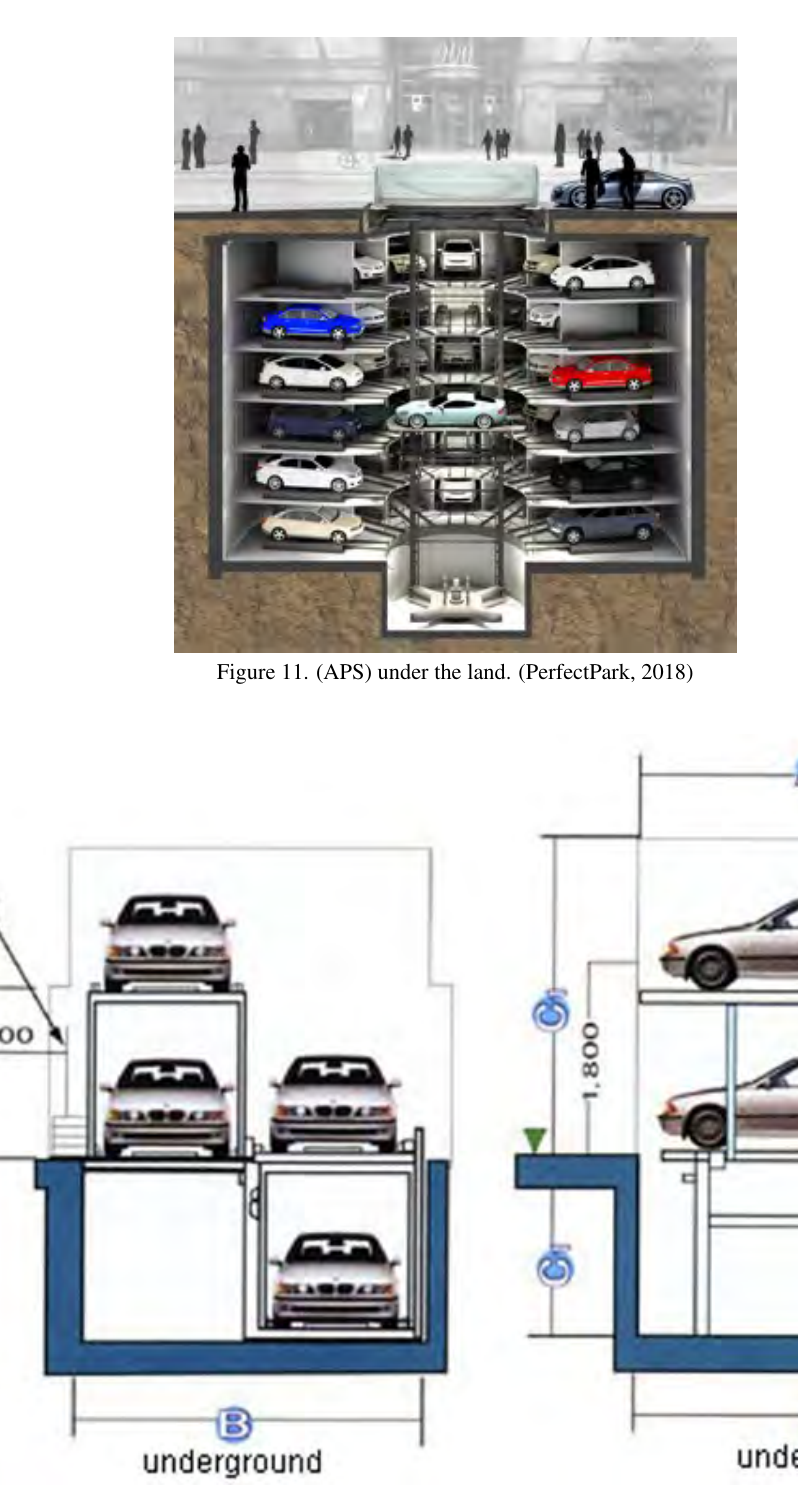
Figure 12. (APS) top & under the land. (STMI,